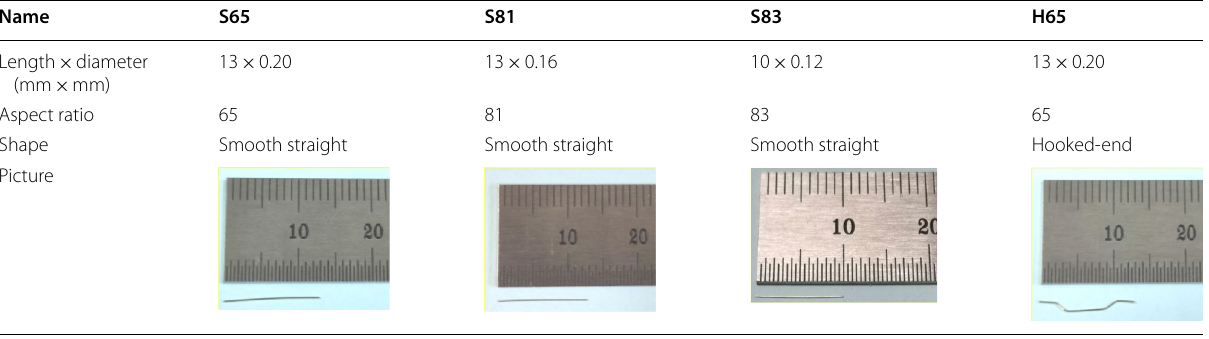
Table 2 Dimentions of steel fibers.